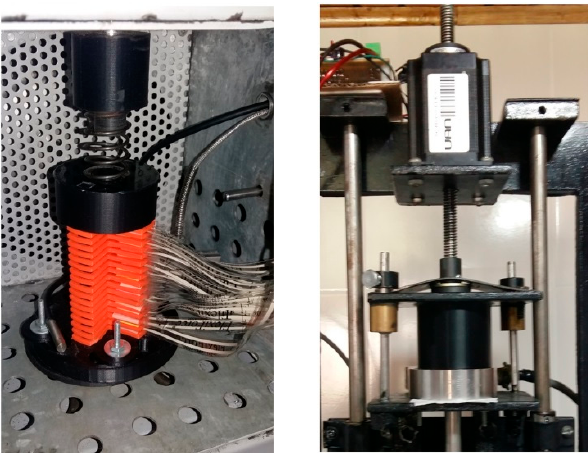
Figure 4. The mechanical setup for collecting the sensors’ data. ( Left ) Multiple FSRs are arranged using a sandwich-like configuration. Mechanical compliance is provided by a spring; ( Right ) Forces are applied through a linear motor and force loops are closed using a load cell.